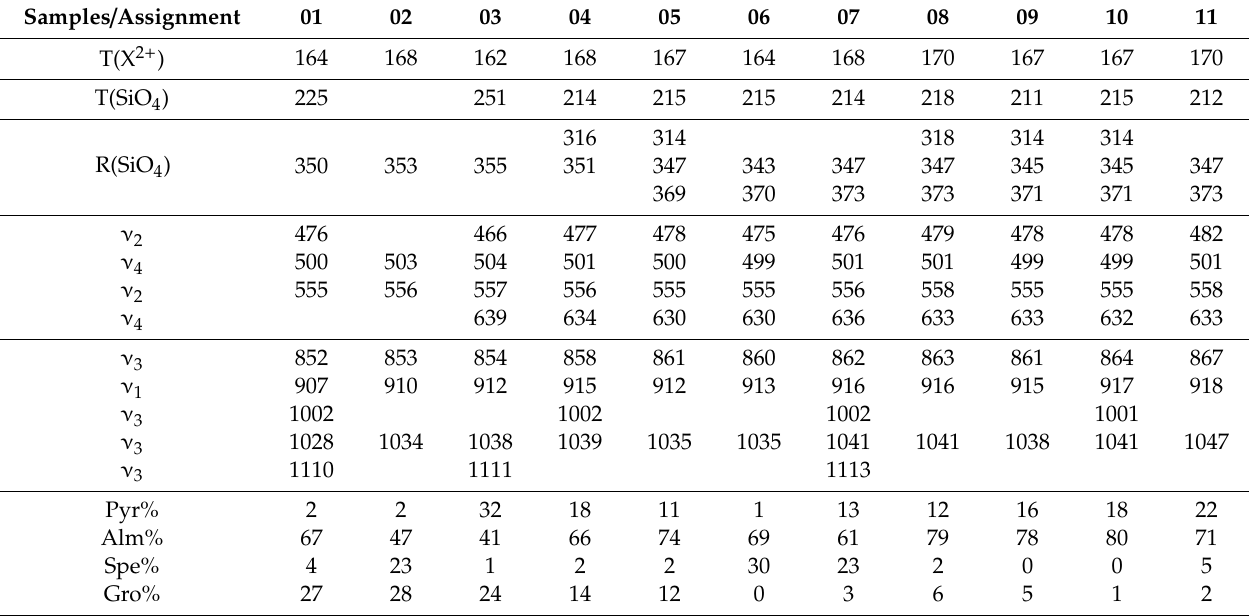
Table 1. Raman bands (cm − 1 ) of selected garnet compositions (mol%) and their mode assignments. Samples /